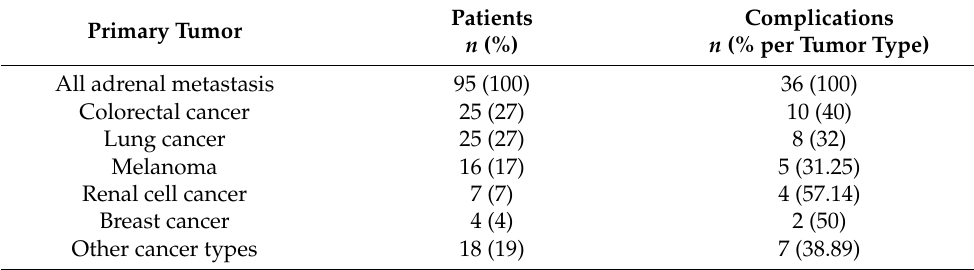
Table 3. The complication rate after metastatic adrenalectomy per tumor type.